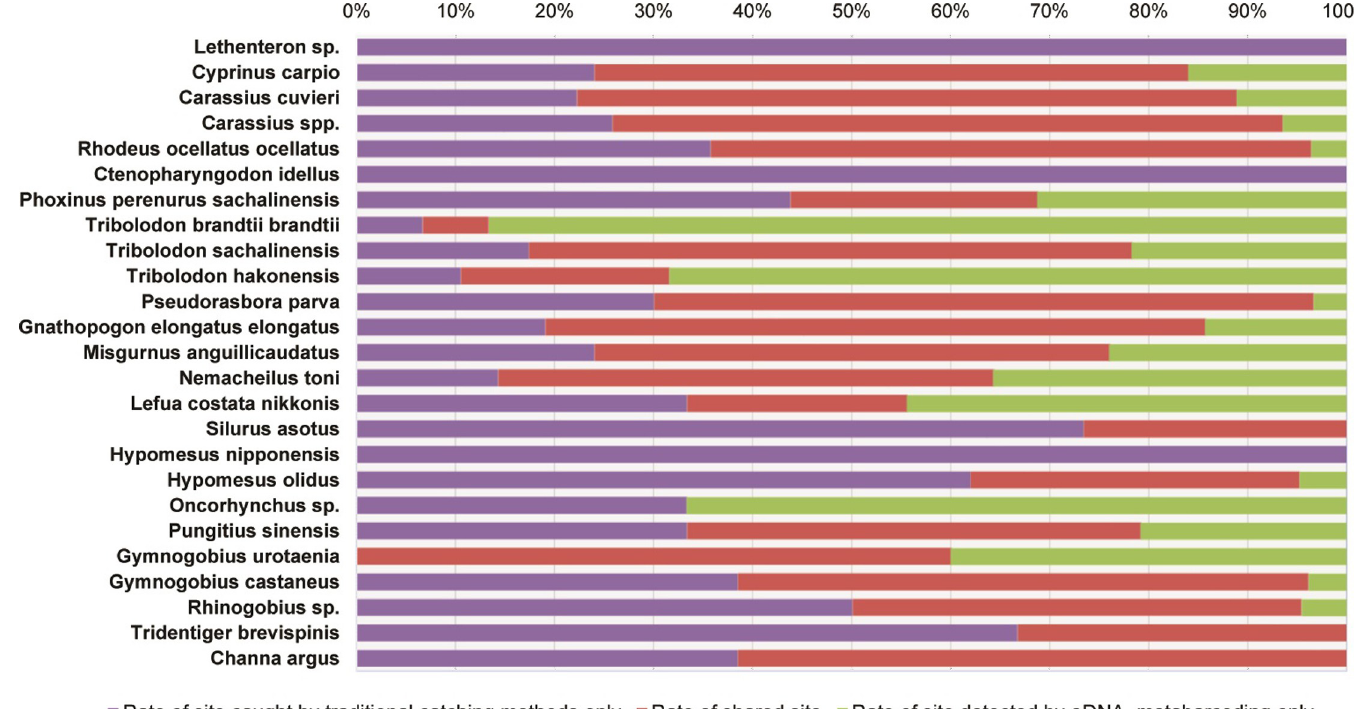
Fig 3. Detections of species in study lakes detected by multiple capture and eDNA metabarcoding methods.